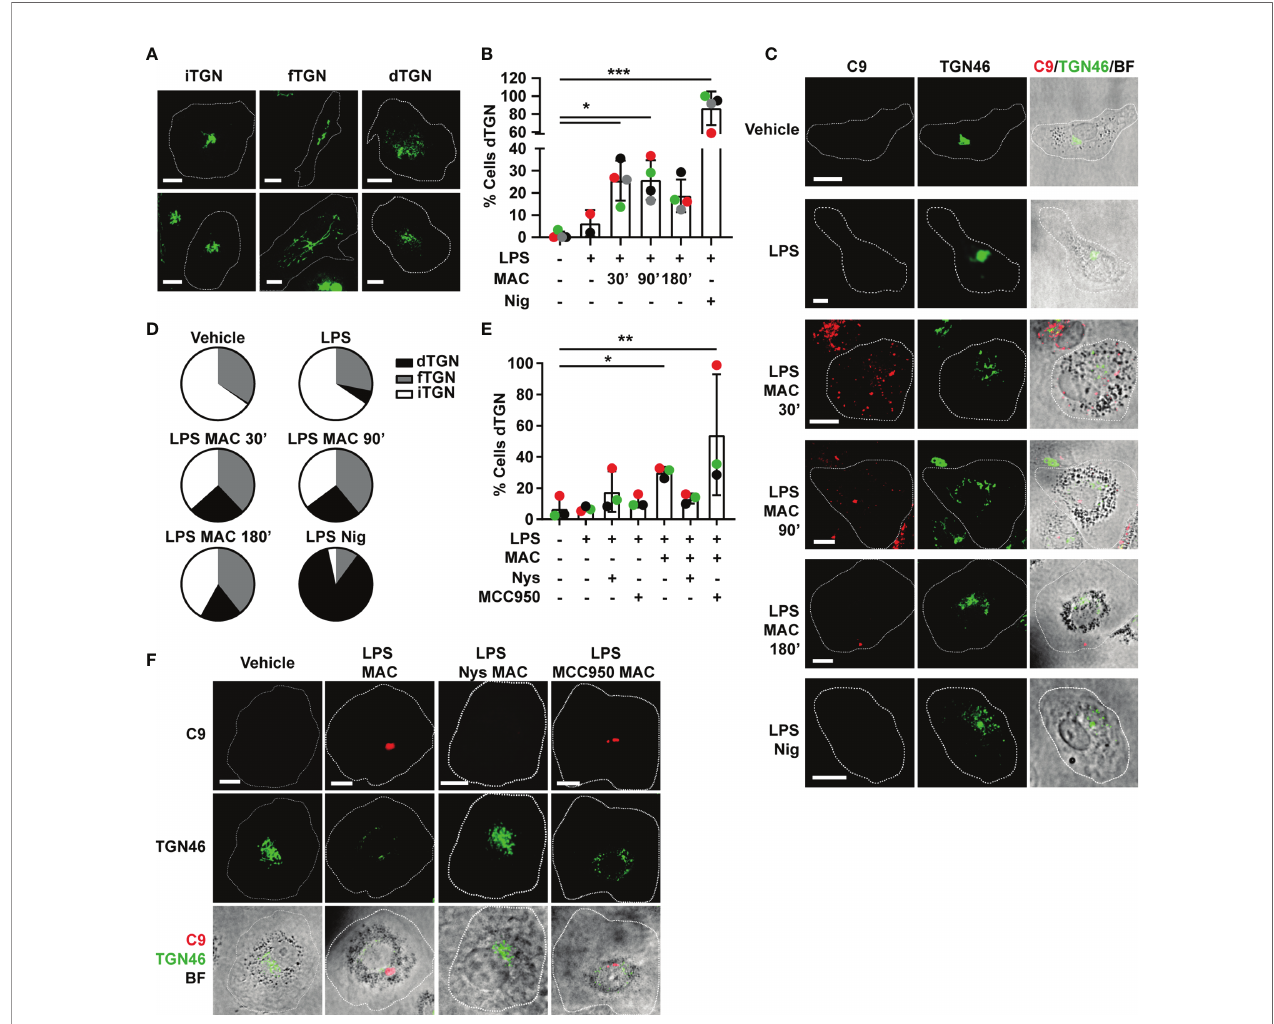
FIGURE 5 | Endocytosis of the MAC triggers disruption of the TGN. (A – D) Human MDMs were treated with vehicles or primed with 1 µg/mL LPS for 3 hrs followed by stimulation with 10 µg/mL anti-CD59 mAb, C5b6, C7, C8 and C9 labelled with AF-647 (MAC) for the indicated time or nigericin (Nig) for 45 mins. (E, F) Human MDMs were treated with vehicles or primed with LPS and the MAC for 3 hrs in the presence or absence of 0.1 µg/mL nystatin (Nys) or 1 µM MCC950. (A) Representative confocal images of the different TGN conformations: intact TGN (iTGN), fragmented TGN (fTGN) and dispersed TGN (dTGN). (B, E) Percentage of cells with dTGN. (C) Representative confocal images of the results analyzed in panel (B) . (F) Representative confocal images of the results analyzed in panel (E) . (C, F) TGN46 (green) and C9 (red) and bright fi eld images (gray). Dashed lines represent cell outlines and scale bars are 10 µm. (D) Pie charts representing the percentage of cells with dTGN, fTGN and iTGN in each condition. (B, E) Data is plotted as mean±SD, each color represents a matched donor and statistical signi fi cance was measured by Friedman ’ s test (*p < 0.05, **p < 0.01, ***p < 0.001). (B – E) Data is representative of 3 (E, F) or 4 (B – D) independent